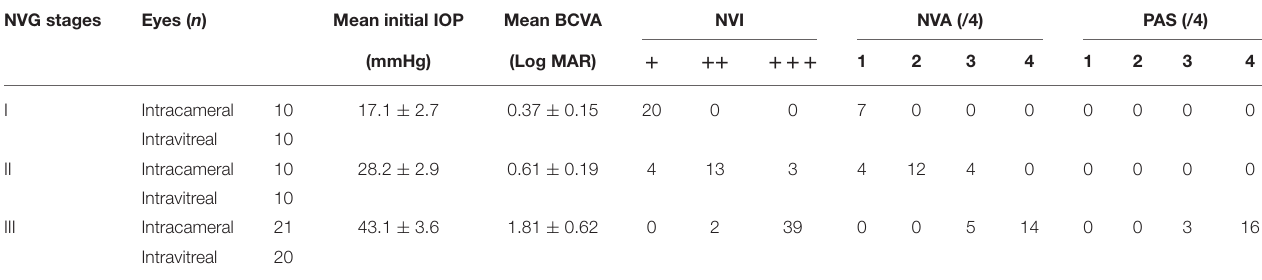
TABLE 2 | The initial statement before conbercept injection. NVG stages